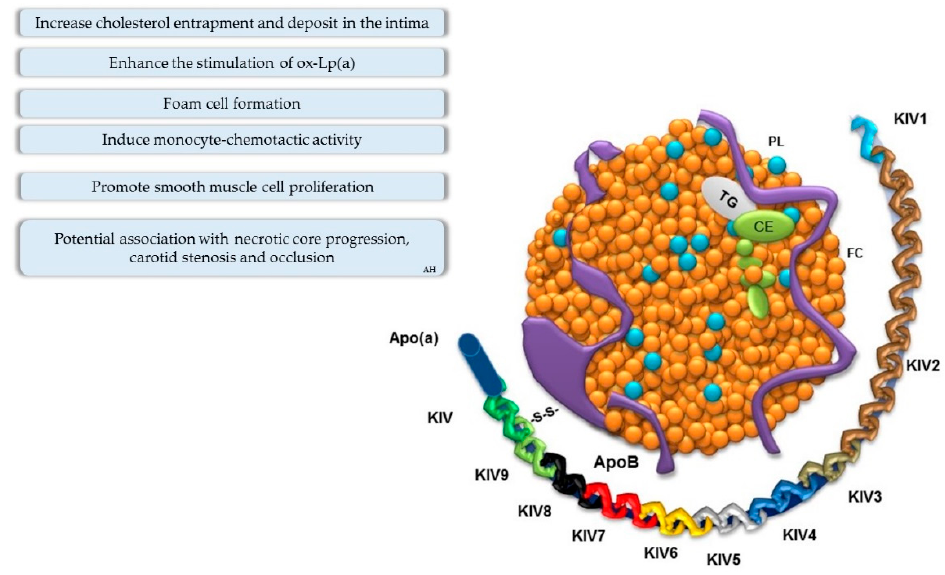
Figure 2. Pathogenic roles and structure of lipoprotein(a) (Lp(a)). Lipoprotein(a) is composed of an LDL-like particle and apolipoprotein(a) (apo(a)), which binds to apolipoprotein B (apoB) through a disulfide bridge. Apo(a) is made up of repetitive amino acid loop-like domains formed by cysteine-rich kringles (so-called kringles (Ks)). PL, phospholipid; FC, free cholesterol; TG, triglyceride; CE, cholesterol ester.